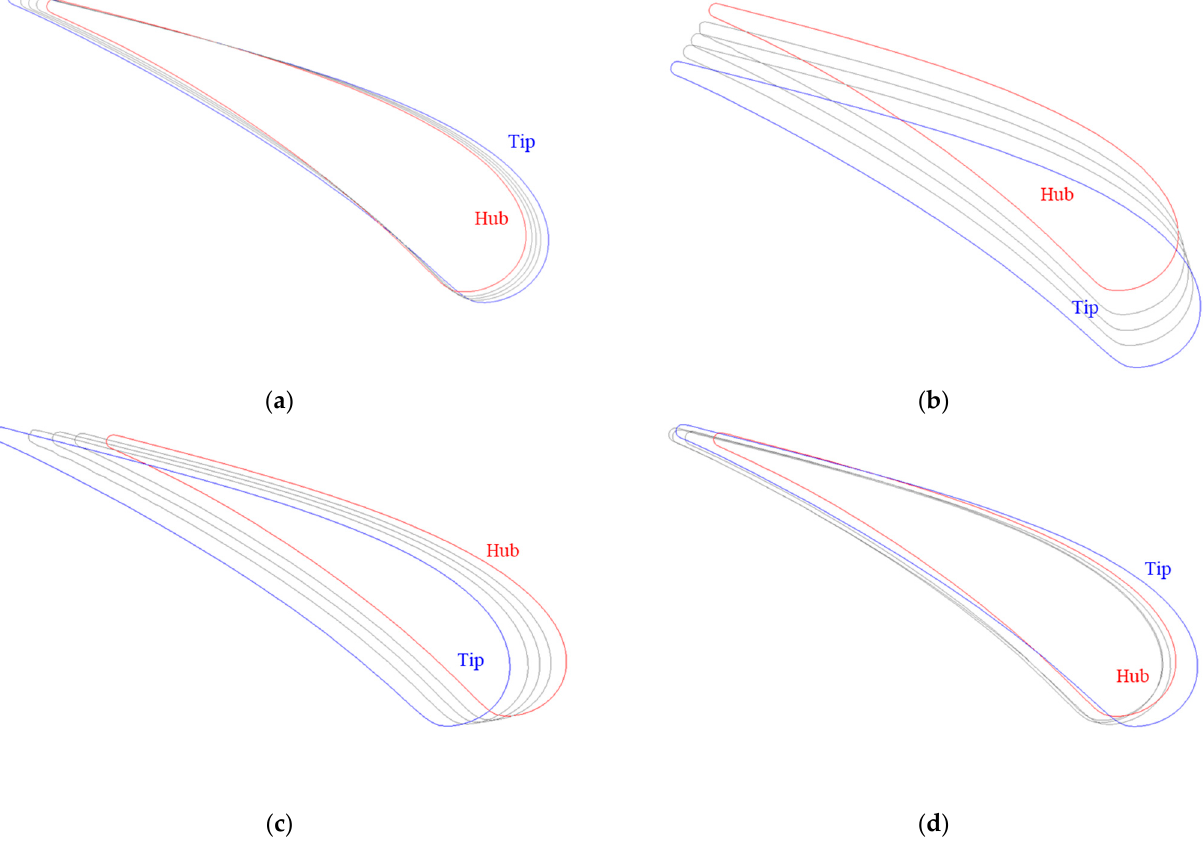
Figure 4. Airfoil profiles of spanwise direction: ( a ) SL0 SP0; ( b ) SL0 SP10; ( c ) SL12 SP0; ( d ) CL12 SP0.